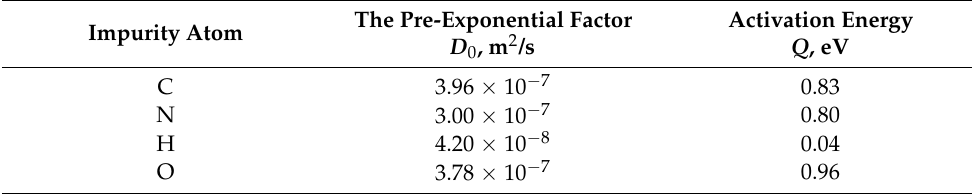
Table 3. Parameters for determining impurity diffusion in α -Fe. Impurity